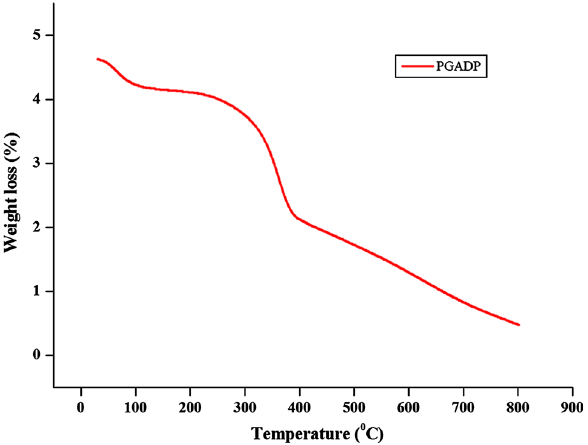
Fig. 6 TGA thermogram of